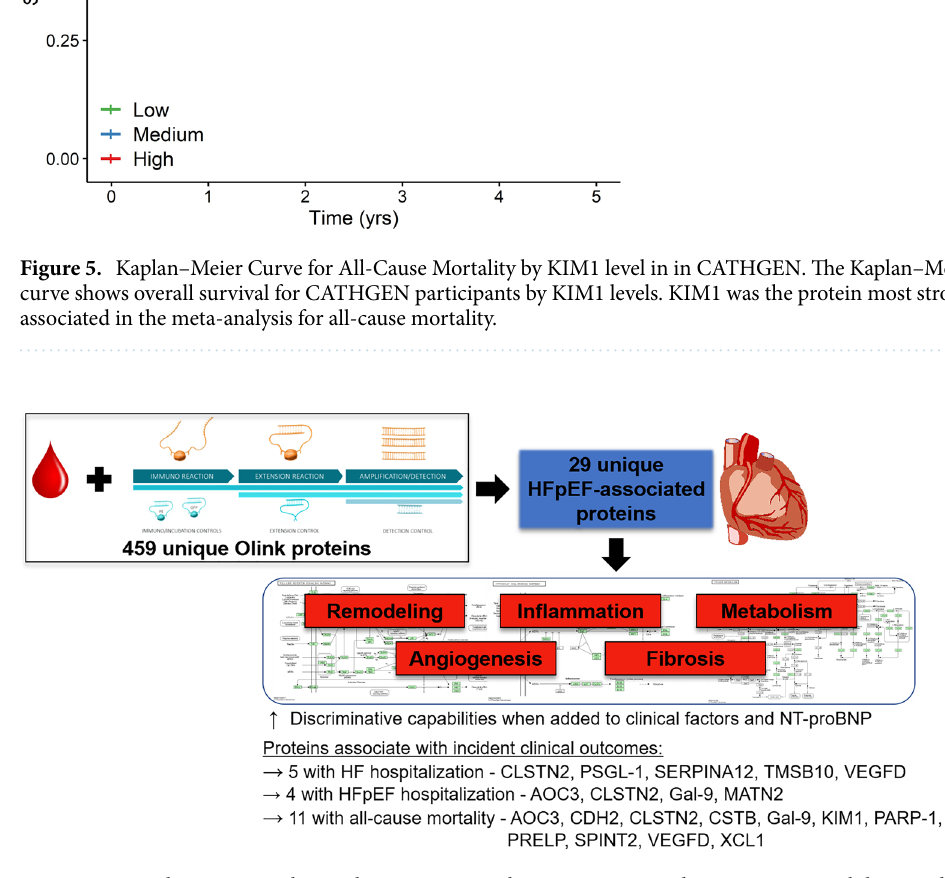
Figure 6. Circulating protein biomarkers associate with HFpEF, improve discriminative capabilities and predict incident events. Assessment of 459 unique Olink proteins in the CATHGEN discovery cohort followed by LASSO and validation in TECOS led to the identification of 29 HFpEF-associated proteins. These proteins were markers of cardiac remodeling, inflammation, metabolism, angiogenesis and fibrosis 22 . GSEA further identified pathways of inflammation and fatty-acid metabolism to be dysregulated. These proteins improved discriminative capabilities for HFpEF prediction and were associated with incident clinical